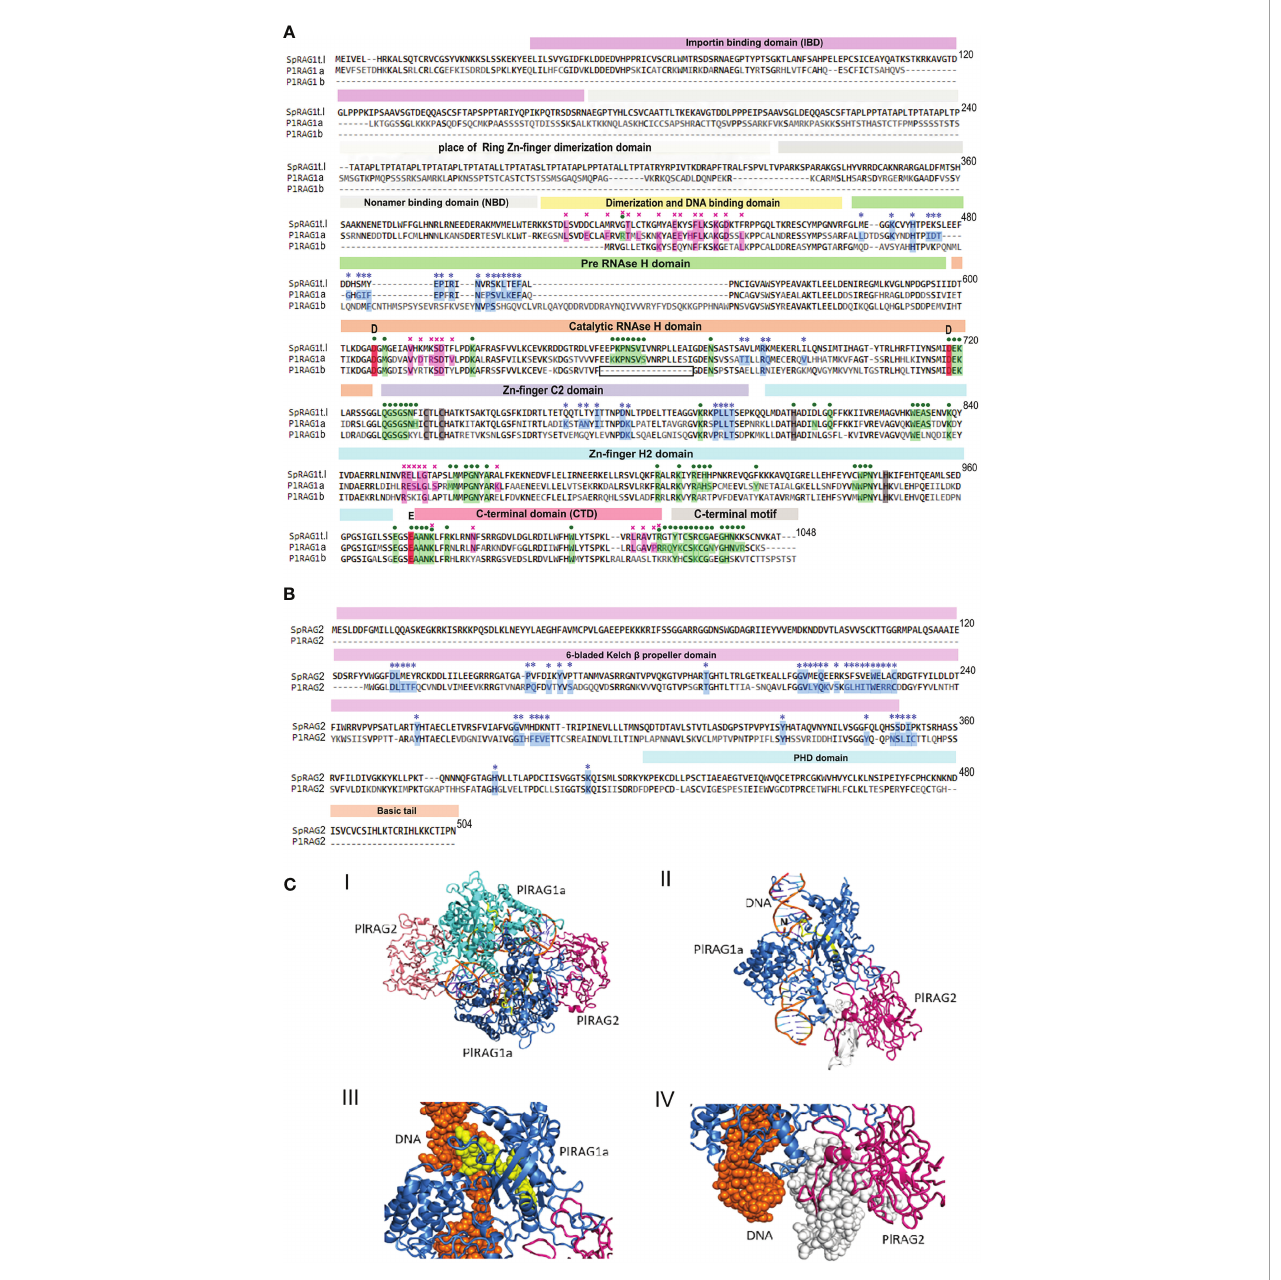
FIGURE 5 Predicted protein structure of PlRAGLs. (A) . sequences alignment of SpRAG1L, PlRAG1a and PlRAG1b with domains (Martin, Vicari et al., 2020). blue stars – contacting residues with RAG2 (RAG1 for RAG2), purple crosses - RAG1 dimerization contacts, green dots - contacting residues of RAG1 with DNA. Grey areas - places that are aligned to the ZDD and NBD domains of Mus musculus RAG1 with low similarity. Boxed section - missing sequence in the catalytic RNH domain in the RAG1Lb protein sequence. (B) . SpRAG2L and PlRAG2L sequence alighnment. (C) . Model structure of P. lividus Rag1L-Rag2L- nicked DNA complex. (i) The P. lividus Rag1/2L_DNA dimeric structure is shown using cartoon representation. One PlRag1L/PlRag2L complex is colored skyblue/hotpink and the other cyan/salmon, with the DNA colored orange. (ii) Monomeric half of the PlRAGL complex with the exposed DNA nick (marked with ‘ N ’ ). The region colored in yellow is missing in the PlRAG1b predicted protein. The region colored in white is missing in the PlRAG2L compared to SpRAG2L (iii) Magni fi cation of the missing DNA binding (in RNAse H domain) region in PlRAG1b (shown in yellow spheres) and its interaction with the nicked DNA helix (shown in orange) (IV) Magni fi cation of the missing region in PlRAG2L (white spheres) as compared with the SpRAG2L. The fi gure was prepared using the PyMol software